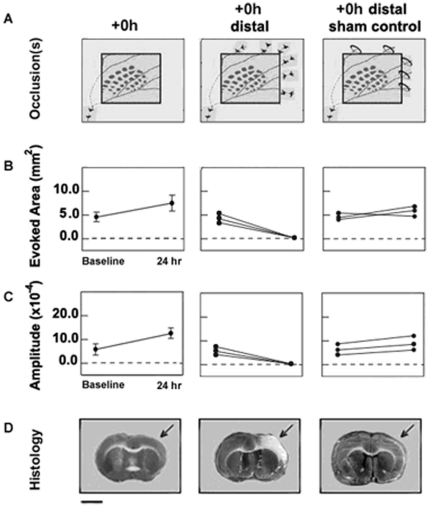
Distal occlusion experiments demonstrate that patent distal branches of MCA are necessary for protective plasticity.(A) Schematics of relative positions of barrel cortex, MCA, and occlusion(s) for +0 h (n = 7; left), +0 h distal (n = 3; middle), +0 h sham distal control (n = 3; right) groups. All three groups underwent identical protocols aside from the additional occlusions of distal branches of MCA performed in the +0 h distal group, and unsecured sutures over the same distal MCA branches in the +0 h sham distal control group. (B, C): Graphs Baseline and 24 hour means and standard errors for area (B) and amplitude (C) of ipsi-ischemic whisker C2 representation for +0 h group, and individual values for +0 h distal and +0 h sham distal control animals. (D): Below each set of graphs is a representative TTC stained coronal slice for each group. The area devoid of staining (arrows) within the +0 h distal subject's left cortex is indicative of ischemic infarct due to an occlusion of the left MCA. Scale bar indicates 5 mm.